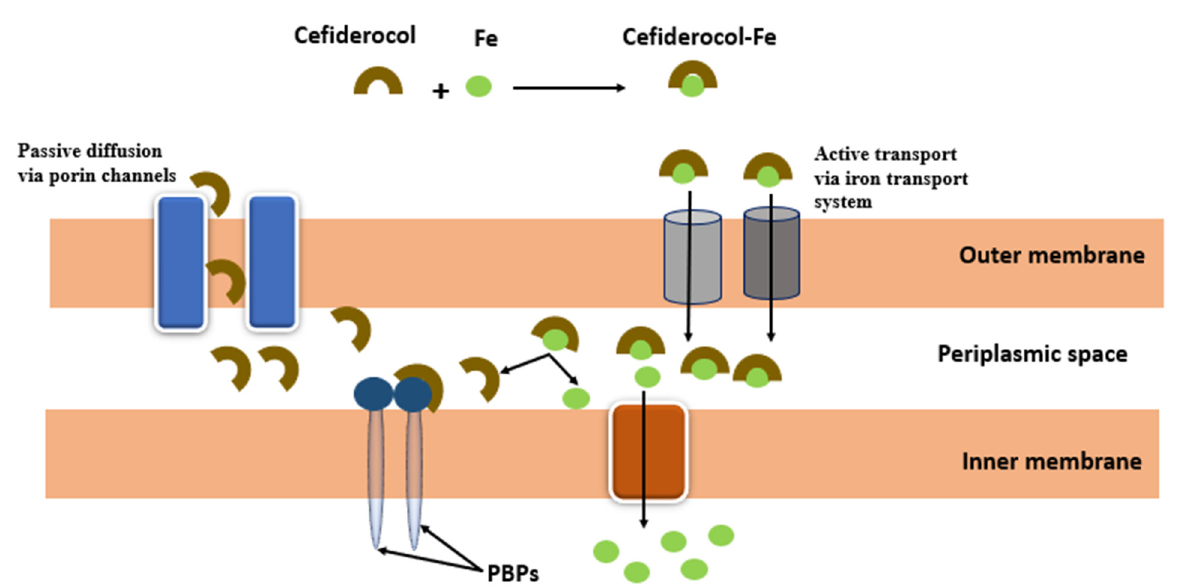
Figure 13 . Mechanism of action of cefiderocol 35 . Figure 13. Mechanism of action of cefiderocol 35